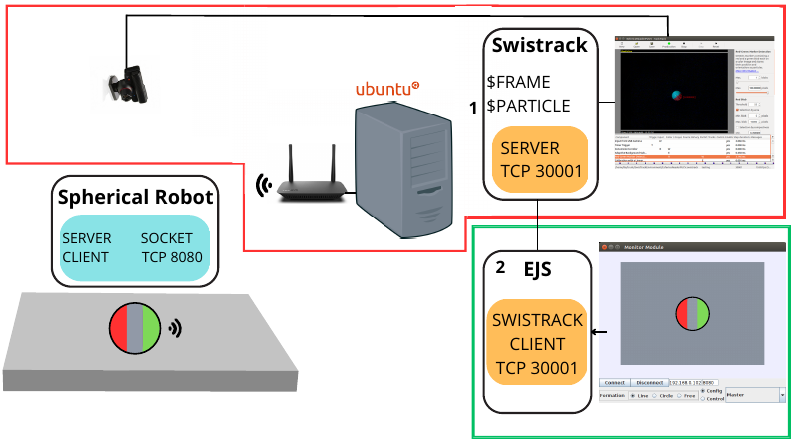
Figure 5. Communication PC module and spherical